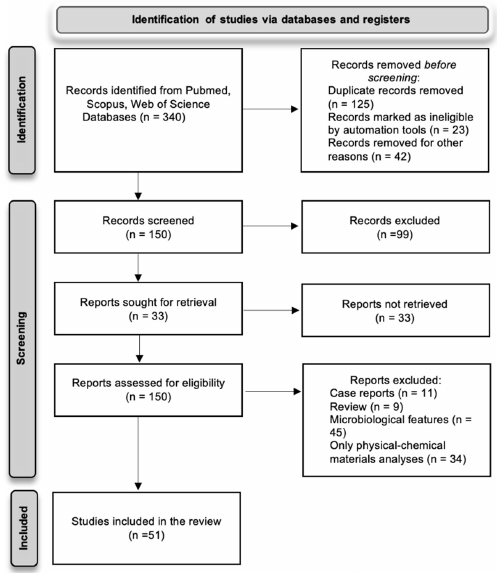
Figure 5. Flow diagram of the included